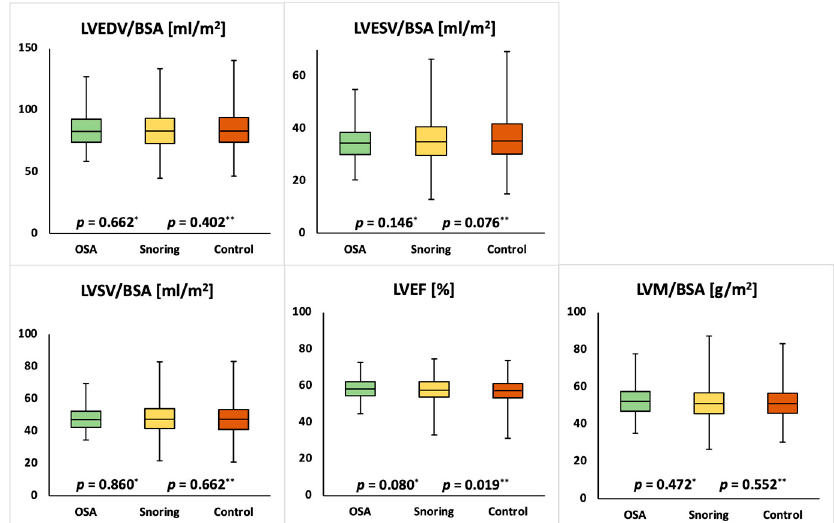
Figure 4. Comparison of left ventricular ejection fraction (LVEF) and end-diastolic volume index (LVEDVI), end-systolic volume index (LVESVI), stroke volume index (LVSVI) and mass index (LVMI) in male individuals with obstructive sleep apnea (OSA), snoring or none of the above. p -values for OSA vs. unaffected (*) and snoring vs. unaffected (**) are reported. No significant difference is shown between individuals with OSA and not affected individuals.